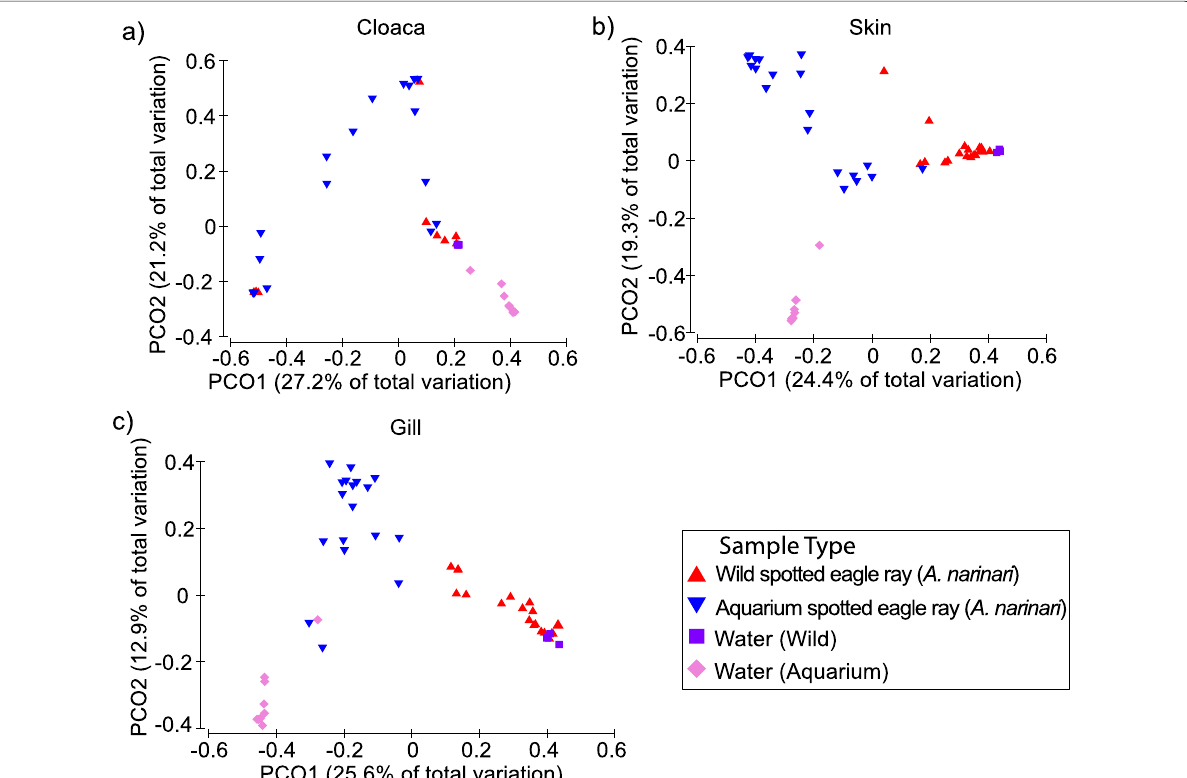
Fig. 3 Principal coordinate analysis (PCoA) of β‑diversity comparison using Bray–Curtis distances between wild whitespotted eagle rays ( Aetobatus narinari ), and aquarium whitespotted eagle rays ( Aetobatus narinari ) for a cloaca, b gill, and c skin samples. Note that wild whitespotted eagle rays harbor different microbial communities than aquarium whitespotted eagle rays, and both aquarium and wild whitespotted eagle rays harbor microbial communities that differ from the surrounding water for all body sites. Interestingly, cloaca samples show higher overlap, suggesting higher similarities compared to more external body sites (gill and skin)